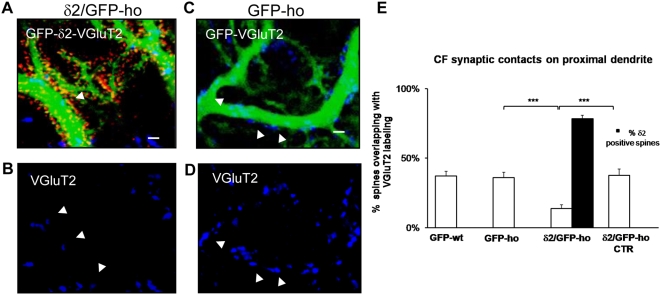
GluRδ2 causes a reduction of CF inputs on the PC proximal dendrite in δ2/GFP-ho mice.(A–D) Immunostaining of CF varicosities (blue) on the PC proximal domain of δ2/GFP-ho mice (A–B) and GFP-ho mice (C–D). (A–B) In δ2/GFP-ho mice, numerous spines bearing GluRδ2 (red, A) appear in the proximal domain. The number of CF varicosities labeled with the VGluT2 antibody (blue, A–B) is reduced relative to GFP-ho mice (C–D). The arrowheads indicate the CF varicosities in the δ2/GFP-ho that are smaller relative to the control. (E) Histogram shows the mean percentage of spines overlapping with VGluT2. A significant reduction is observed in the δ2/GFP-ho mice relative to the GFP-ho and δ2/GFP-ho CTR groups and also to GFP-wt mice. These results show that in presence of GluRδ2, indicated as the percentage of spines expressing GluRδ2 (black column), the number of CF contacts is strongly reduced. *** p<0.001. Error bars indicate SEM. Scale bars in A–D = 2 µm.